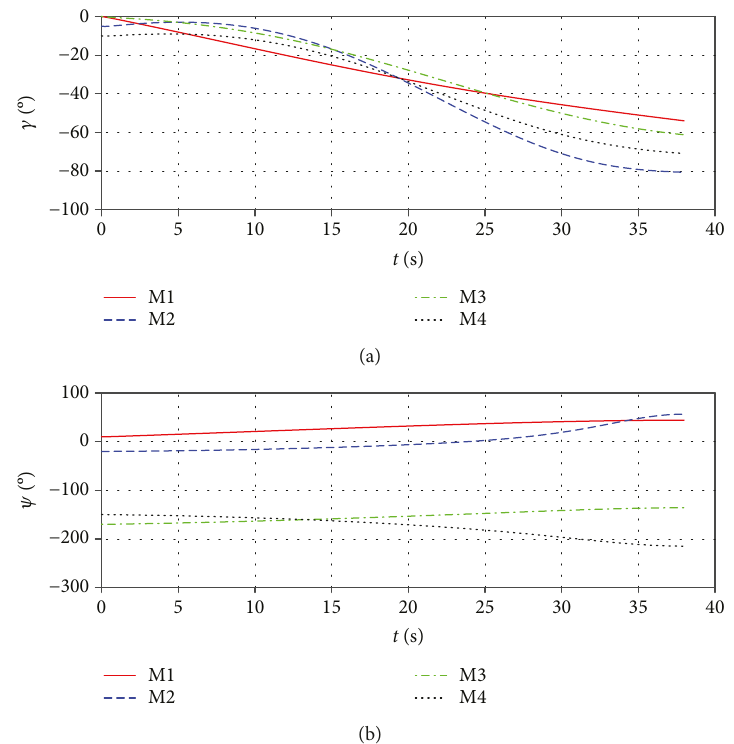
Figure 9: Curve of angles with impact time control.